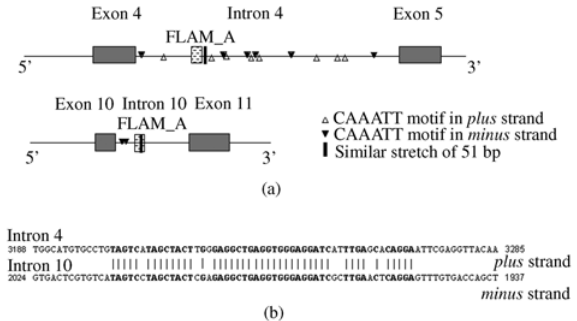
Figure 4 - ( a ) Relative positions of FLAM_A Alu repeats and CAAATT motifs on introns 4 and 10 of the KAL-1 gene, and ( b ) alignment of the similar 51 bp stretch (E value: